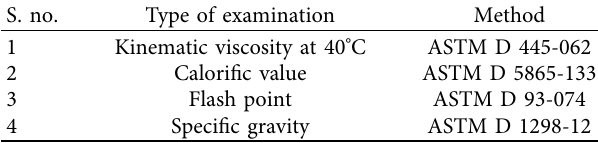
Table 1: Biodiesel property testing methods.